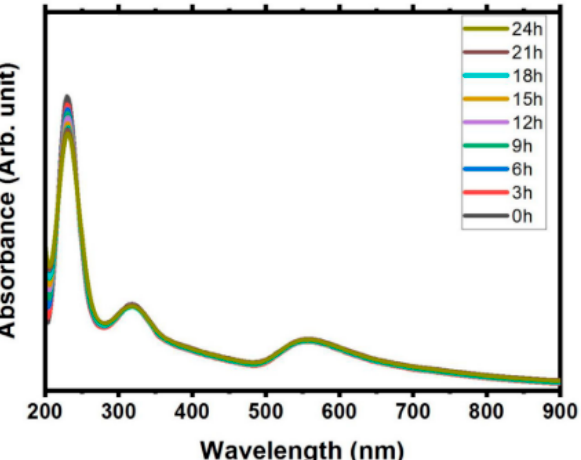
Figure 3. Absorption study from the ablation metal (Gold and Sn) immersed in pure water in time dependent over a day (retrieved with permission from reference [40]). Table 8. A summary of characterisation method of gold nanoparticle, function, advantages and disadvantages of each